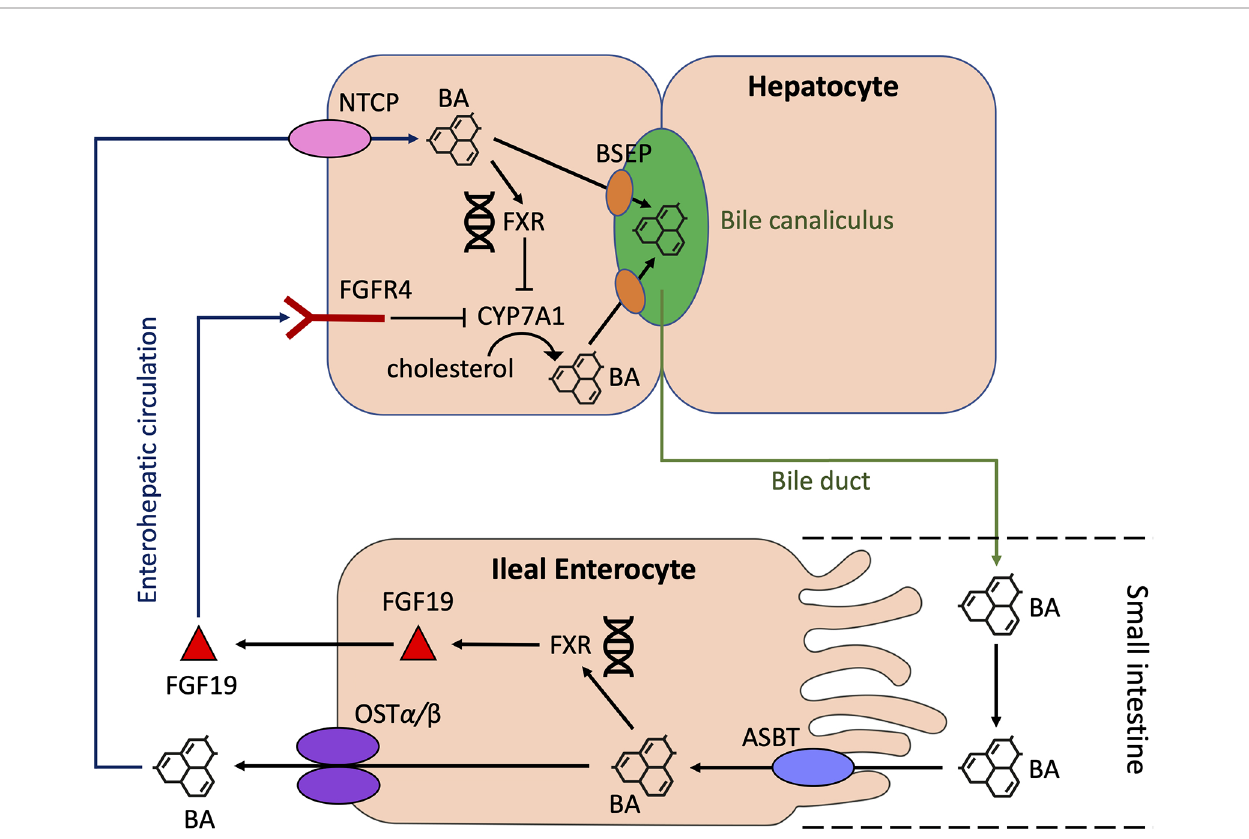
FIGURE 2 | Regulation of BA synthesis by FXR and FGF19 in humans. Cholesterol 7 a -hydroxylase (CYP7A1) initiates the conversion of cholesterol to PBAs through the classical pathway in hepatocytes. BAs are transported from hepatocytes into the bile canaliculus through the bile salt export pump (BSEP). BAs then enter the small intestine via the common bile duct. In the terminal ileum, enterocytes absorb BAs through the apical sodium-dependent bile salt transporter (ASBT). Here, BAs can activate the nuclear BA receptor, farnesoid X receptor (FXR), which results in the upregulation of fi broblast growth factor 19 (FGF19) and subsequent release of FGF19 into the portal circulation. BAs also enter the portal circulation via the organic solute transporter a / b (OST a / b ) located in the basolateral membrane of enterocytes. BAs from the portal circulation are reabsorbed back into the liver via the Na + -taurocholate cotransporting polypeptide (NTCP). FGF19 also binds to fi broblast growth factor receptor 4 (FGFR4). Both these actions result in the inhibition of CYP7A1, thus resulting in the downregulation of BA synthesis. BA, bile acid; CYP7A1, cholesterol 7 a -hydroxylase; BSEP, bile salt export pump; ASBT, apical sodium-dependent bile salt transporter; FXR, farnesoid X receptor; FGF19, fi broblast growth factor 19; NTCP, Na + -taurocholate cotransporting polypeptide; FGFR4, fi broblast growth factor receptor